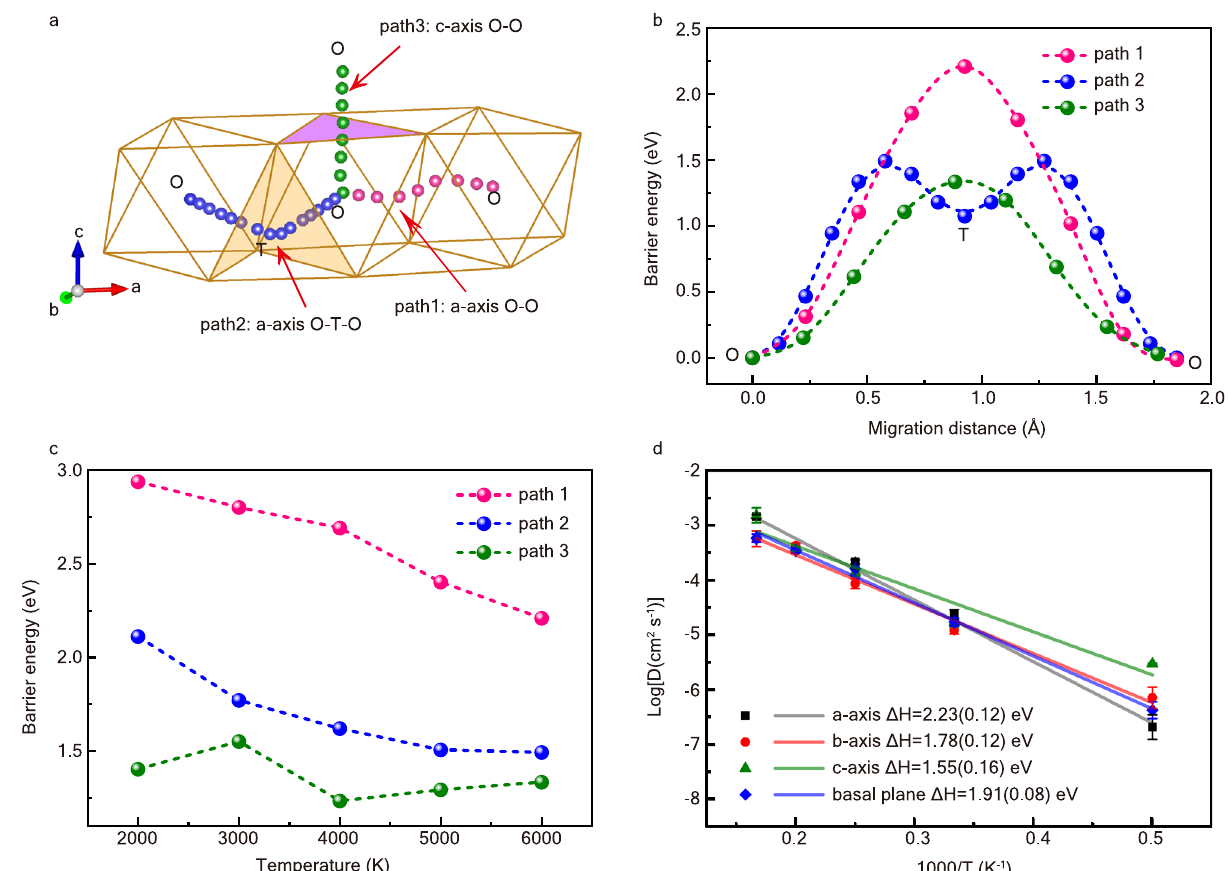
Fig.2|MigrationpathsandbarrierenergiesofH-ionsinhcp-FeH 0.25 at360GPa and2000 – 6000K.a ThemigrationpathsforH-ionsinhcp-Fe.Theoctahedraland tetrahedralsitesarenotedwithOandT.PinkandbluespheresrepresentO-Odirect (path 1) and O-T-O indirect (path 2) paths in the basal plane. Green spheres represent the O-O path (path 3)along the c-axis. The framework of Feispresented with blown lines. b The H-ion migration barrierenergiesasa function of migration distance at 360GPa and 6000K. c Barrier energies for different H-ion migration